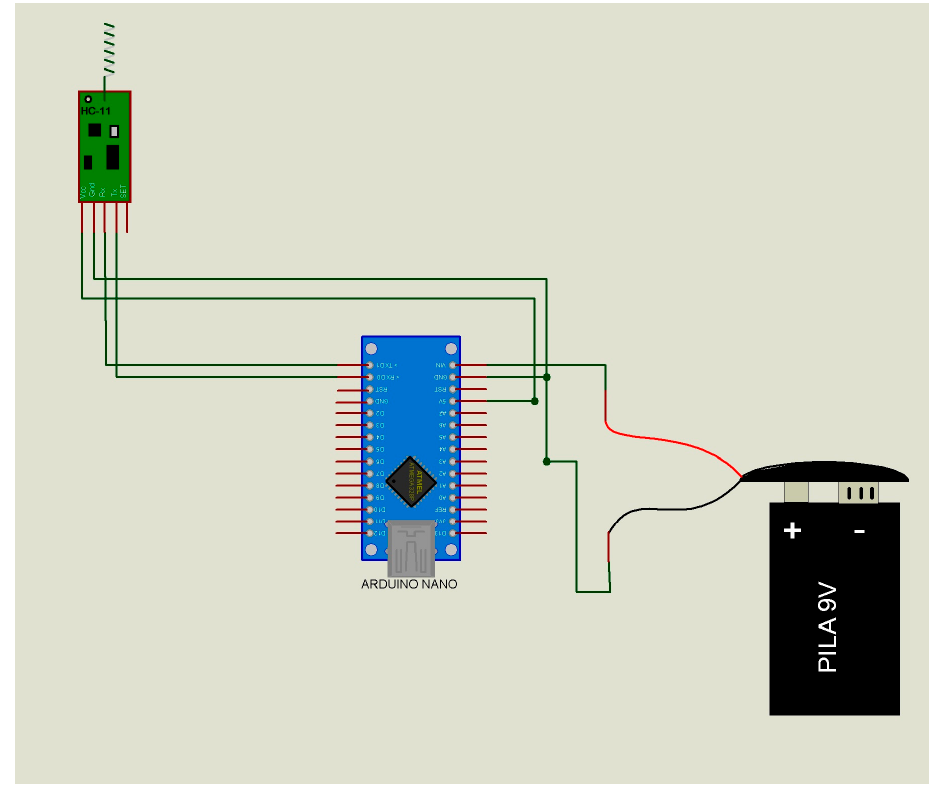
Figure 2. Schematic diagram of the data receiver/transmitter module or “slave”. Receiver mode: the missing people file from master modules. Transmitter mode: the subject’s identity data is sent to the master module only in case the subject is searched (Table 1 (A,B)). Figure taken and adapted from Polanco et al. [5].